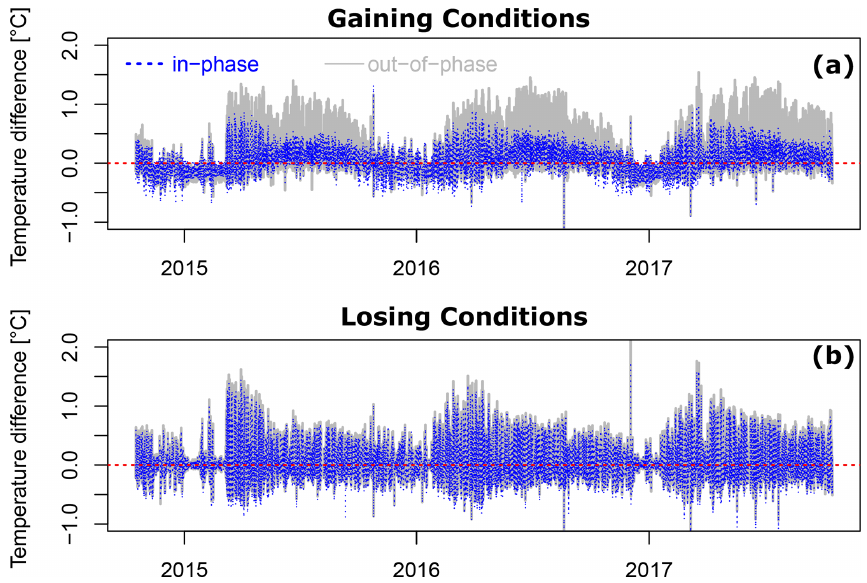
Figure 7. Temperature differences between river and exfiltrating hyporheic fluxes under (a) gaining and (b) losing in-phase and out-of-phase fluctuations of diel river temperature and daily groundwater table